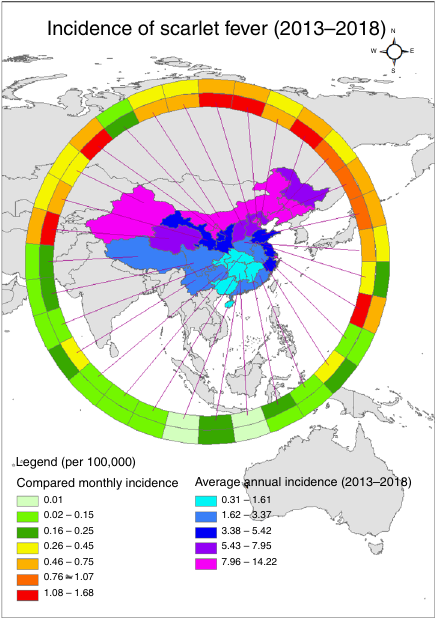
Fig. 8 Comparison of spatiotemporal distribution of scarlet fever cases during summer and winter holidays and school terms in China, 2013 – 2018. Average monthly incidence of scarlet fever per 100,000 people in the 31 Chinese provinces investigated. The outermost ring bears data for summer and winter breaks, and the innermost ring bears data for when school is in session. Choropleth maps of the average annual incidence of scarlet fever, by region, based on the annual incidence per 100,000 people in China during 2013 – 2018. Source data are provided as a Source Data fi